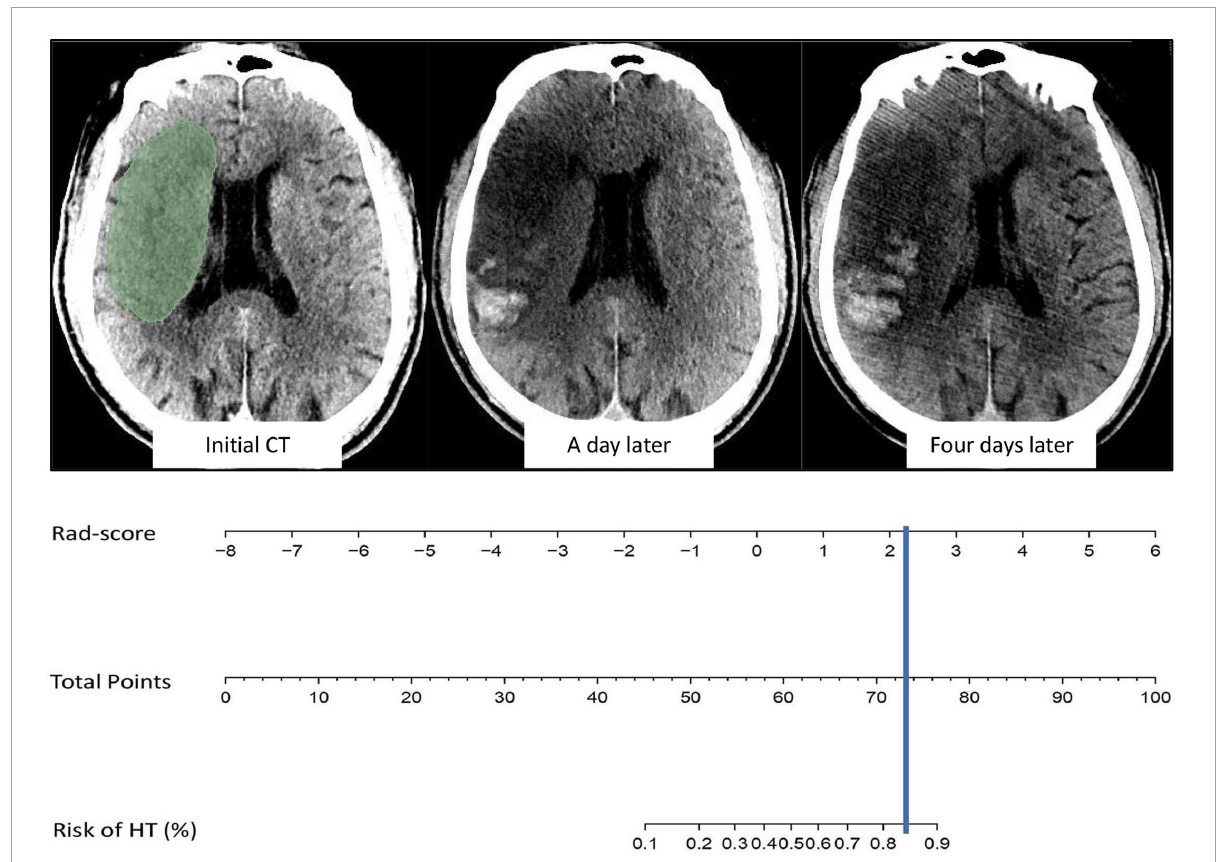
FIGURE5 Example of model visualization prediction. The cerebral infarct area was segmented and radiomics features were extracted, and the value of Rad-score was then incorporated into the model for calculation. The results indicated an 80–90% probability of HT in the future, which was confirmed on head CT one and four days after intravenous